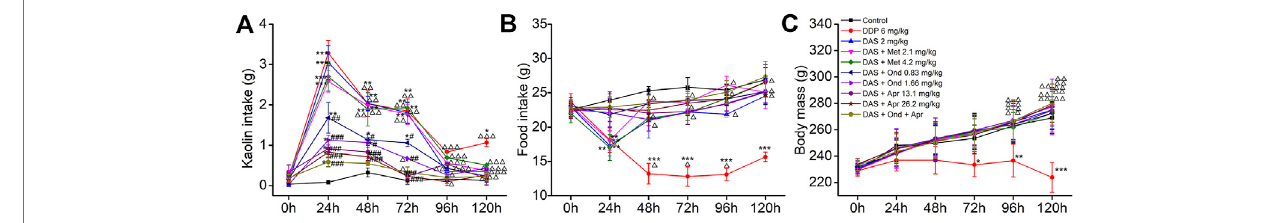
FIGURE4 | Effects ofdifferentantagonists on DAS-induced kaolin intake (A) food intake, (B) and body mass, (C) in rats. Control: saline, p. o.; DDP:6 mg/kg, i. p.; DAS: 2 mg/kg, p. o.; and Metoclopramide: Met, 2.1 and 4.2 mg/kg, i. p.; Ondansetron: Ond, 0.83 and 1.66 mg/kg, p. o.; Aprepitant: Apr, 13.1 and 26.2 mg/kg p. o.; Met, Ond, and Apr were administered 30 min before DAS. The results of kaolin and food intake are shown as cumulative daily amounts (g) during 24 h periods up to 120 h after treatment. Body mass was weighed once per day. The data are expressed as mean ± SEM. Statistical signi fi cance was assessed using the one-way ANOVA. * p < 0.05, ** p < 0.01, *** p < 0.001 vs. the control group, and # p < 0.05, # # p < 0.01, # # # p < 0.001 vs. the DAS group, △ p < 0.05, △△ p < 0.01, △△△ p < 0.001 vs. at 24